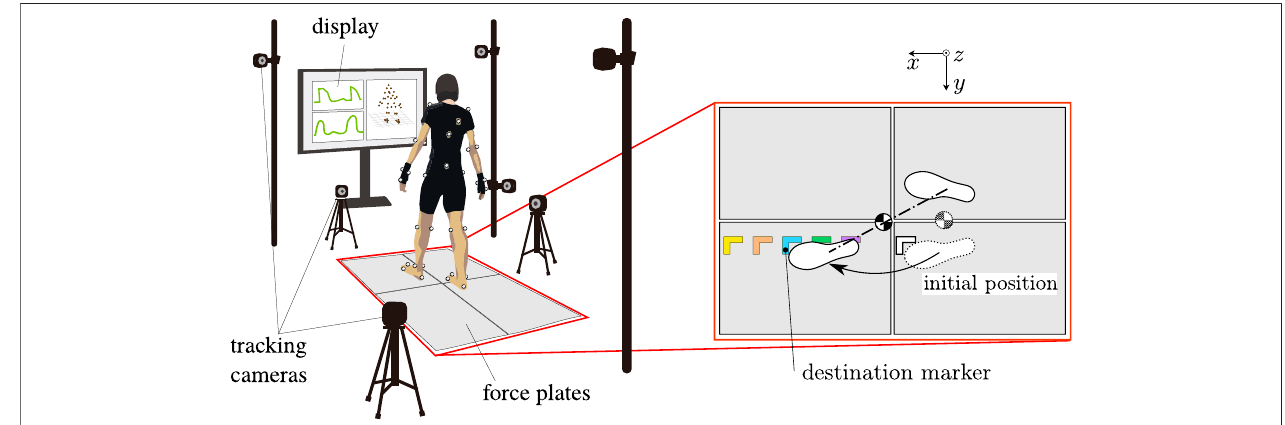
FIGURE4| Set-upofthemotionmeasurementsystemwith11infraredcamerasand4forceplates.Thefoot-landinglocationsarespeci fi edbymarkertapesputon the force plates.